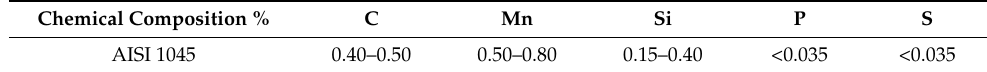
Table 1. AISI 1045 material chemical composition.